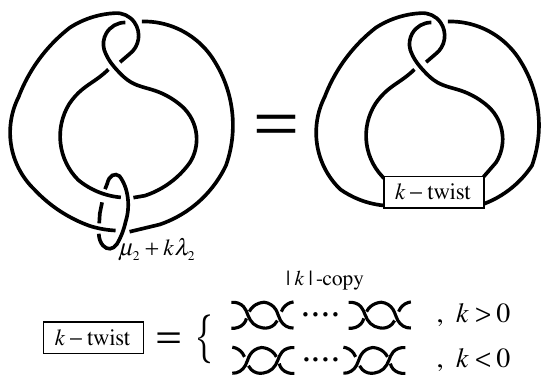
) (cid:22) is a twist knot K k . For 1 2 + k(cid:21) 2